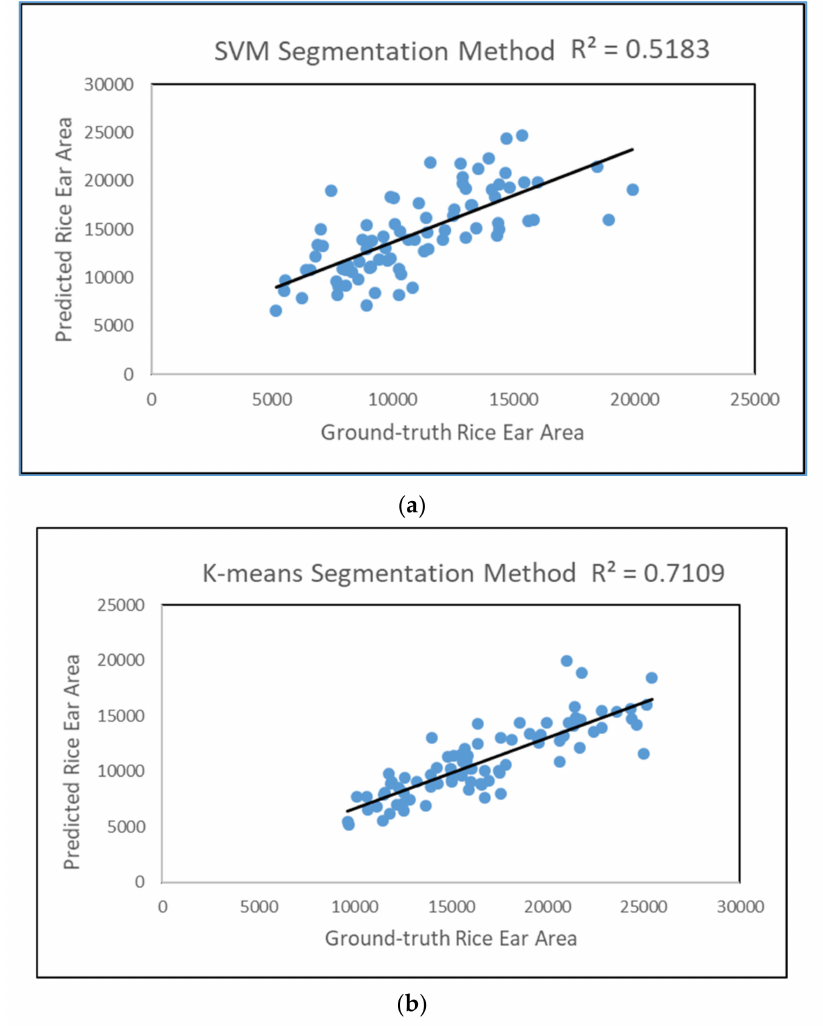
Figure 8. Segmentation accuracy of rice ear region: ( a ) SVM segmentation method; ( b ) K-means segmentation method.